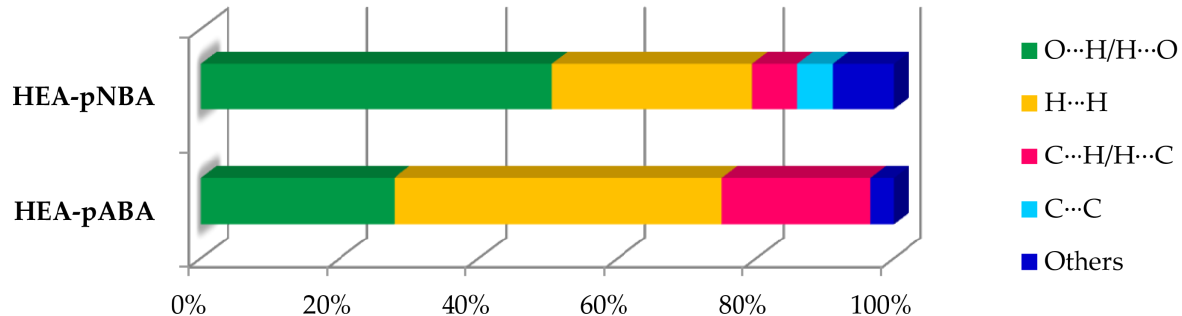
Figure 5. Relative contributions of various intermolecular contacts to the Hirshfeld surface area in HEA- p NBA and HEA- p ABA discussed in detail in the text.